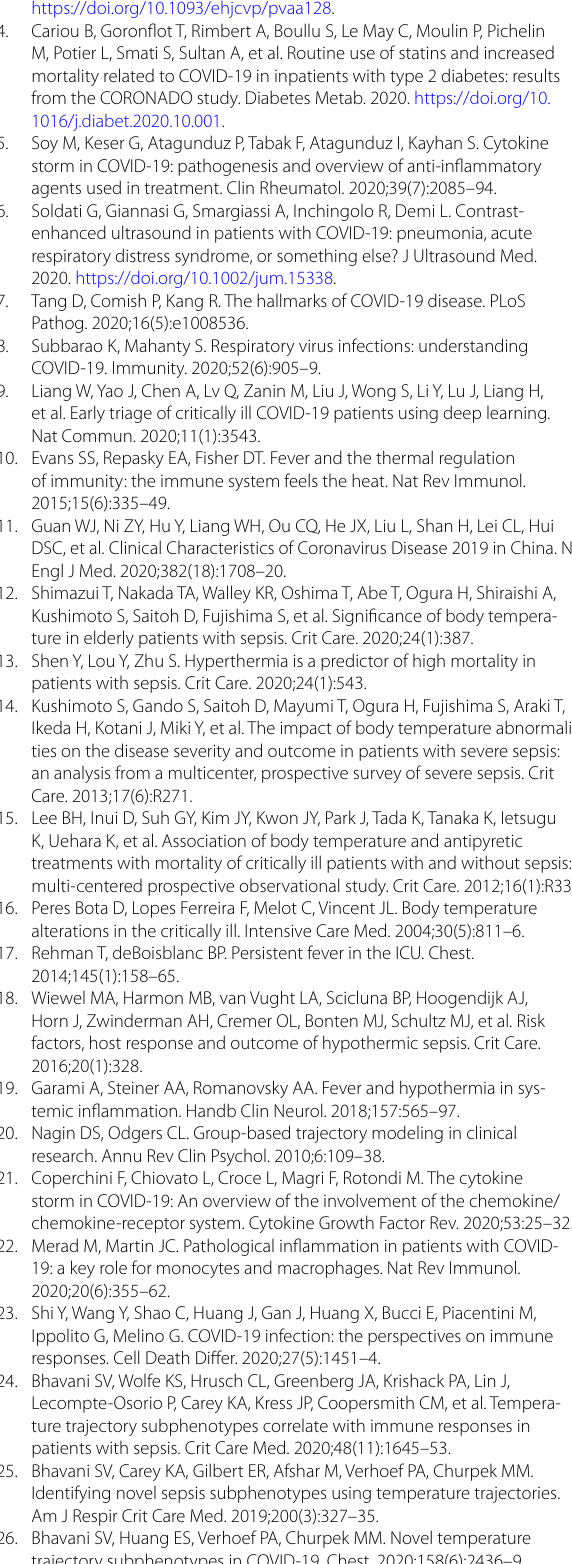
Additional file 1: Table S1. Selection of different group-based temperature-trajectory phenotypes. Fig. S1. Four temperature